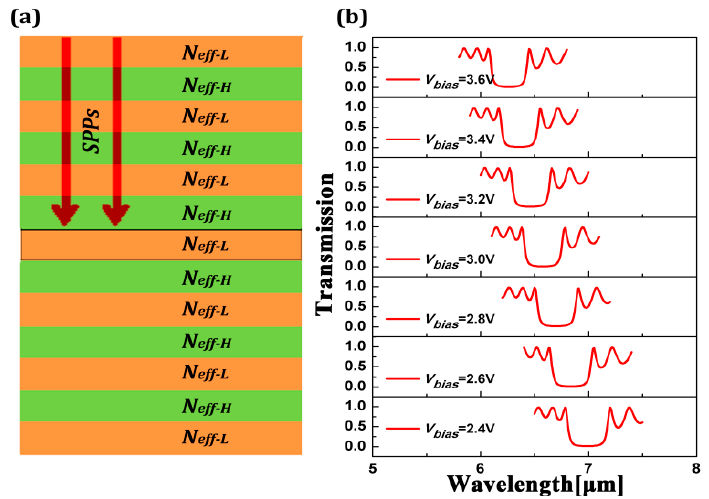
Figure 3. ( a ) The principle model of the graphene waveguide, and N eff-L and N eff-H are the effective reflective index of graphene at sections of d 1 = 5 nm and d 2 = 10 nm, respectively; ( b ) The position of the stop-band in the transmission spectrum can be controlled by changing the bias voltage V bias .